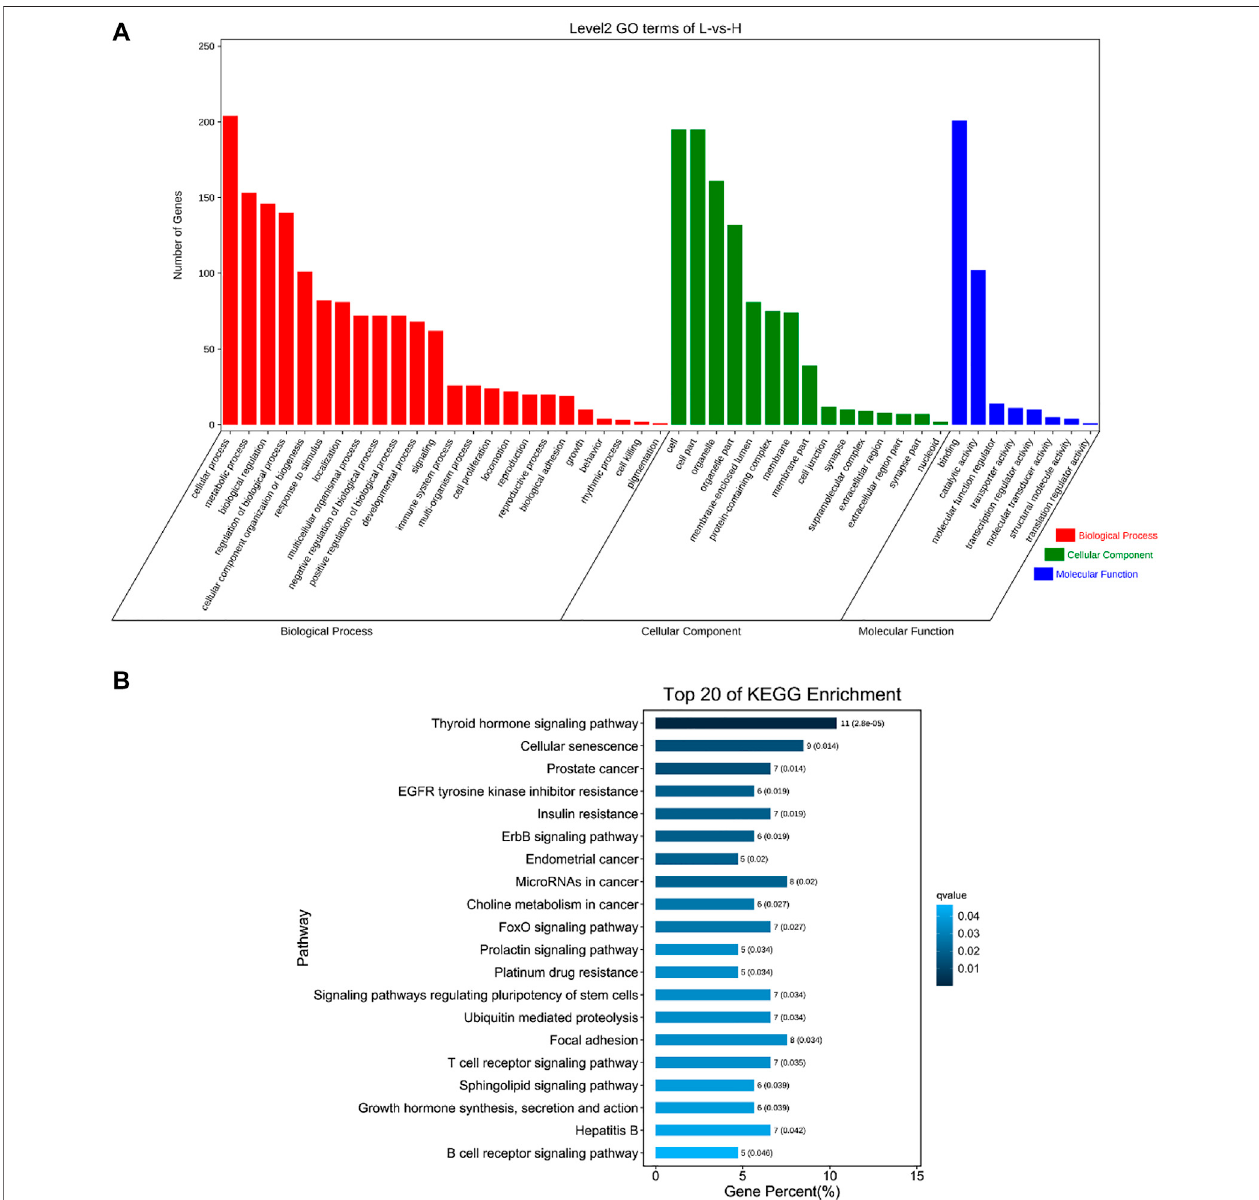
FIGURE5| GOandKEGGanalysisofsourcegenesofDEcircRNAs. (A) GOenrichment.TheabscissaisthesecondaryGOterm,andtheordinateisthenumberof genesinthisterm.DifferentcolorsshowdifferenttypesofGOterms,redrepresentsBiologicalProcess,greenrepresentsCellularComponent,bluerepresentsMolecular Function. (B) KEGG enrichment.Using thetop 20pathwayswiththesmallestQ valuetomake amap, the ordinate isthepathway,theabscissa istheenrichmentfactor, the size of the column indicates the number of genes, the bluer the color, the smaller the Q value.